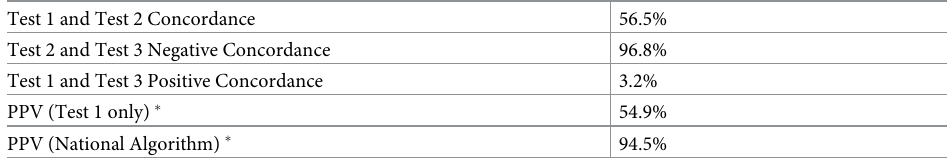
Table 1. Performance characteristics of different HIV tests or testing algorithm, NAIIS